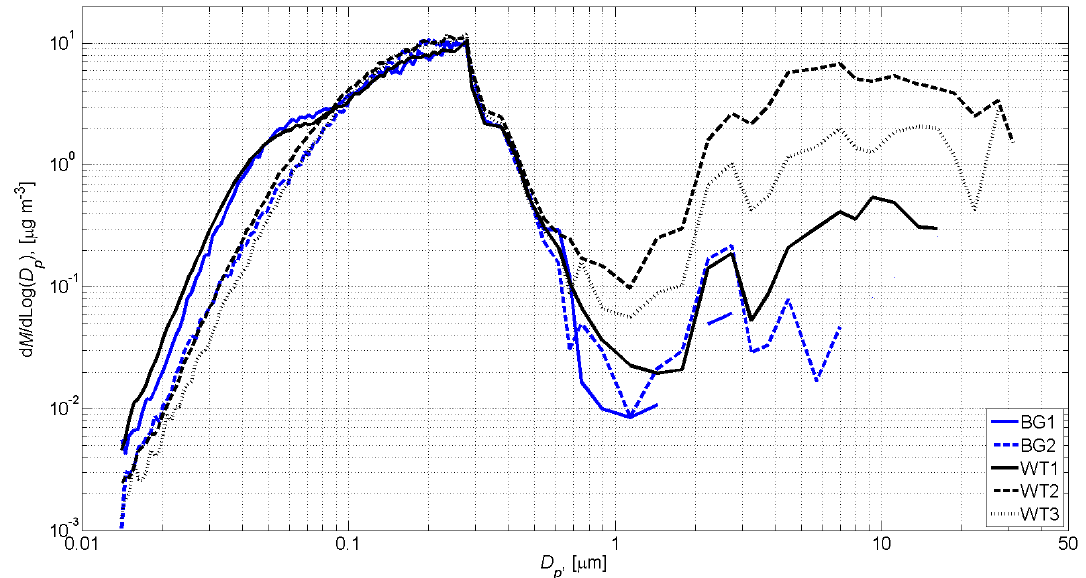
Figure 4. Mass distribution averages for the background’s (BG1 and BG2) and work task’s ( WT1 , WT2 , and WT3 ) concentrations calculated from the SMPS + OPC measurements.